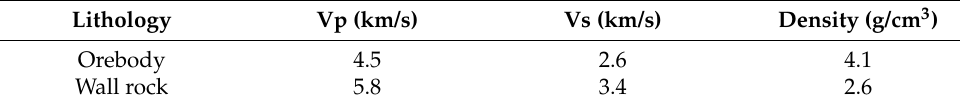
Table 3. Elastic parameters used in models F and G.